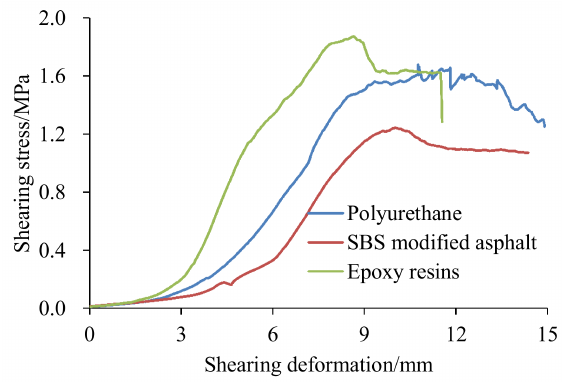
Figure 7. Stress-deformation curves of PPM-10 + AC-20 composite specimens during shear test with 0.3 mm adhesive